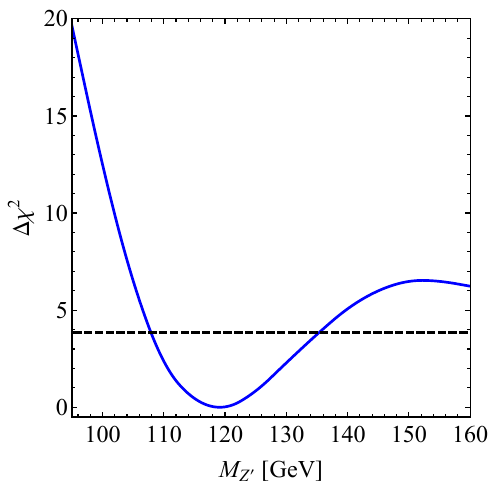
Figure 11 . (cid:1) (cid:31) 2 distribution in the U(1) D model as a function of the Z 0 -boson mass following from the LHCb measurement [17]. The benchmark parameters (5.6) have been used to obtain the shown predictions. The dashed black line corresponds to (cid:1) (cid:31) 2 = 3 : 84, i.e. the 95% CL for a Gaussian